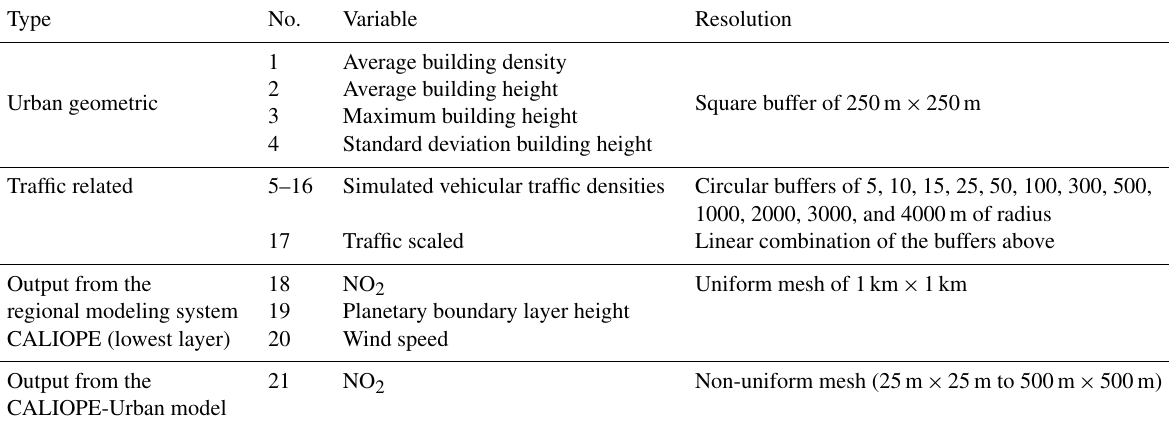
Table 1. The microscale LUR model contemplates the use of these 21 potential